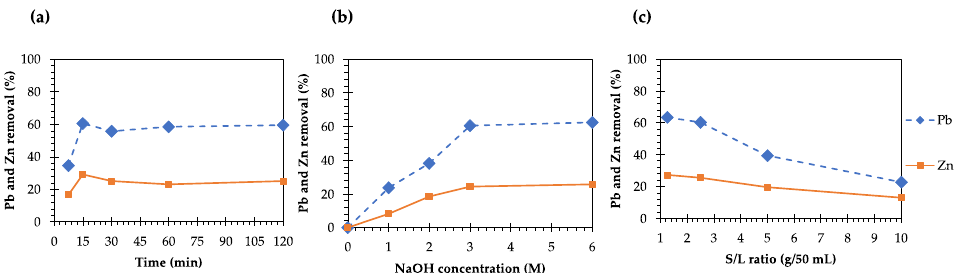
Figure 1. Pb and Zn removal efficiencies from ZPLRs: ( a ) Effects of leaching time when 2.5 g ZPLRs was leached in 50 mL of concentration 3 M NaOH and shaken at 120 strokes per minute in the water bath at 25 °C; ( b ) effects of NaOH concentration when 2.5 g ZPLRs was leached in 50 mL of different NaOH concentration and shaken at 120 strokes per minute in the water bath at 25 °C; and ( c ) effects of S/L ratio when various amounts ZPLRs were leached in 50 mL of 3M NaOH concentration and shaken at 120 strokes per minute in the water bath at 25 °C.